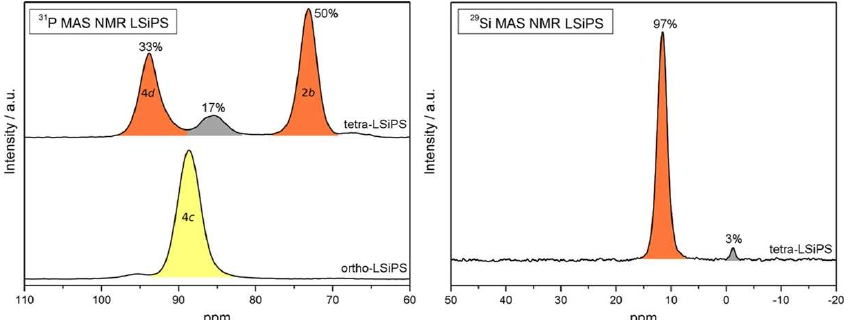
Figure 12. (Left) 31 P NMR spectra of tetrahedral (top) and orthorhombic (bottom) LSiPS. (Right) 29 Si NMR spectra of tetrahedral LSiPS [41] .